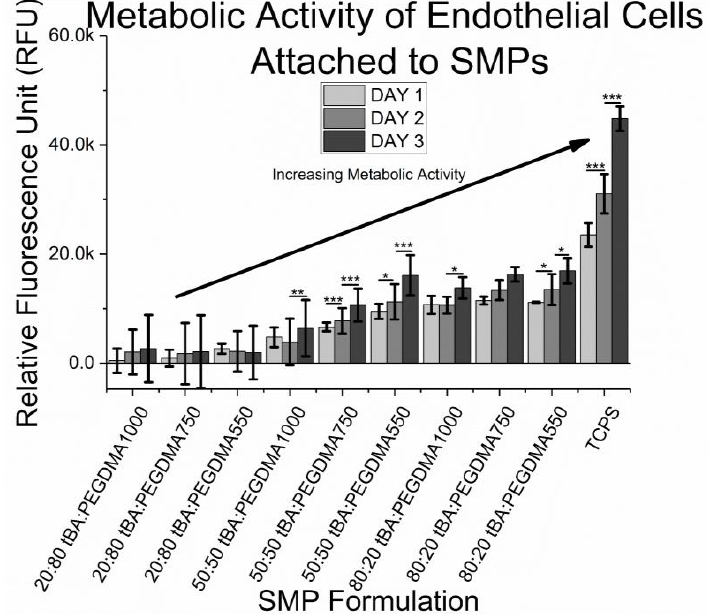
Figure 9. Cytocompatibility of SMPs. There is evidence of increasing metabolic activity, prominently 72 h after cell introduction, but some samples show evidence of metabolic activity increasing just 48 h after cell seeding. Samples that are cytotoxic have little metabolic activity as compared to samples that are cytocompatible, confirming a lack of HUVEC presence. Significance was determined using one-way ANOVA to determine significant differences between samples of a given wt % ratio and between individual samples. * corresponds to p < 0.05, ** corresponds to p < 0.01, *** corresponds to p <